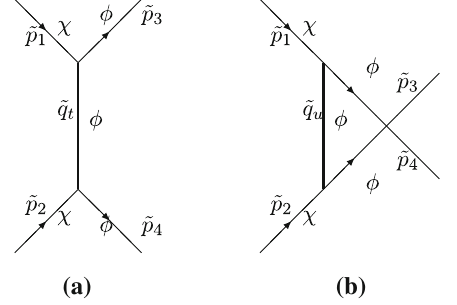
Fig. 1 The leading order Feynman diagrams that contribute to χχ → φφ . Here ˜ q = ˜ p − ˜ p = ˜ p − ˜ p ˜ q = ˜ p − ˜ p = ˜ p − ˜ p t u 1 3 4 2 , 1 4 3 2 are the 4-momenta carried in the internal lines. Note that the s-channel is forbidden by kinematics in Minkowski space. In a curved space, in general, one expects the s-channel to be opened due to the violation of energy/momentum conservation [16]. In this case where the space is taken to be nearly Minkowski in the intervals corresponding to average time for each process, one expects a small contribution to the scatter- ing amplitudes due to the opened s-channel processes. However this contribution may be neglected since we take the space to be almost Minkowski in these time intervals by the condition (5)